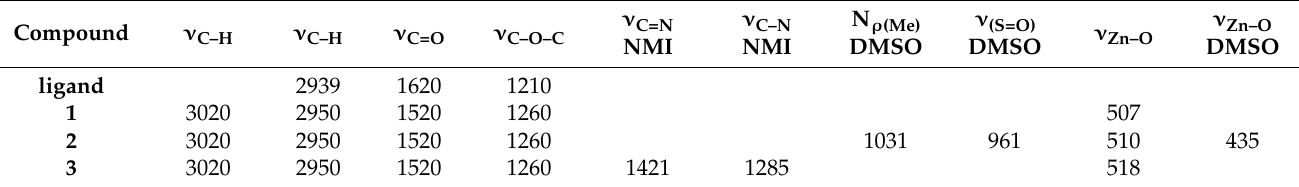
Table 1. IR frequencies (cm − 1 ) of BMIP, 1 , 2 and 3 .